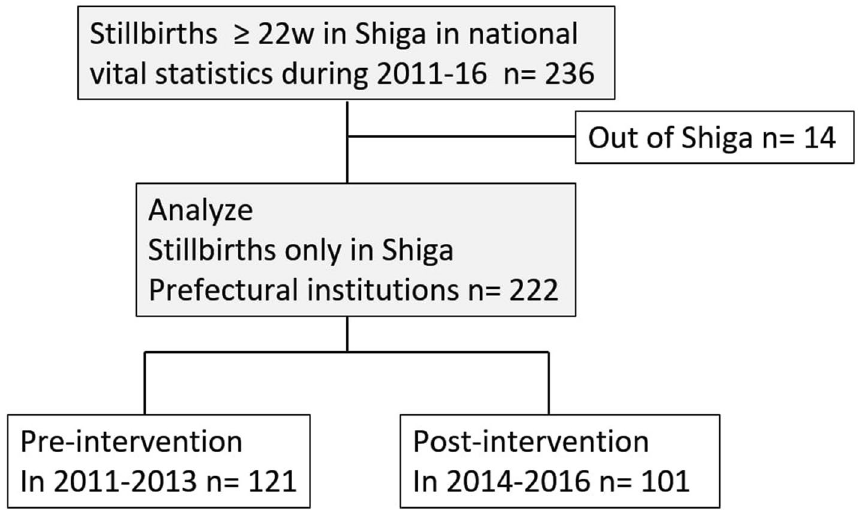
Figure 1. Overview of this study.